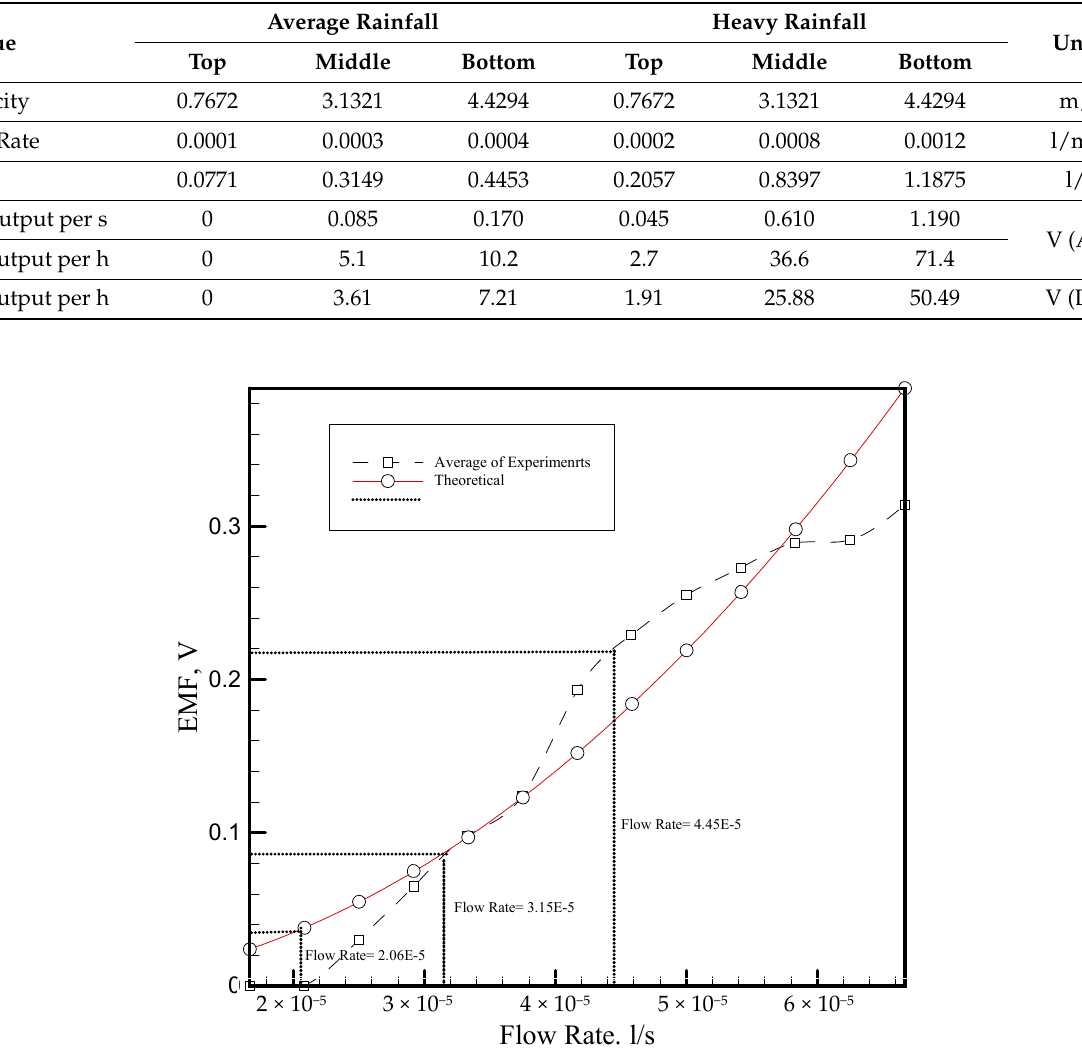
Figure 12. Estimating power output using extrapolation of data.